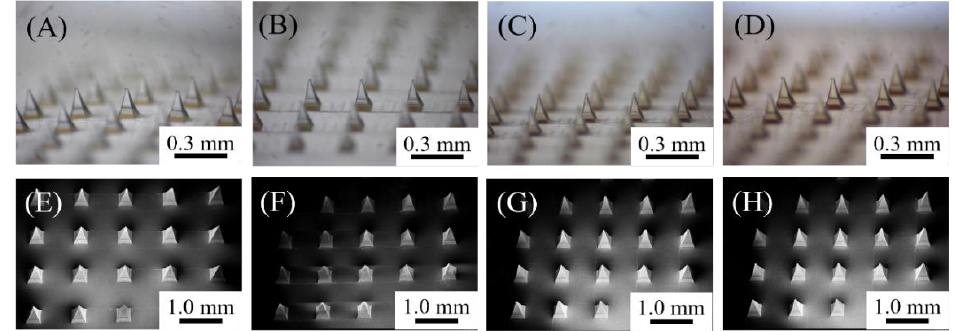
Figure 3. Light microscope photograph of MN patches with various loading conditions: ( A ) pure Gel, ( B ) GA-loaded, ( C ) QAGN-loaded, and ( D ) GA + QAGN-loaded MN patch. The corresponding SEM images of MN patches with various loading conditions are shown in ( E – H ).